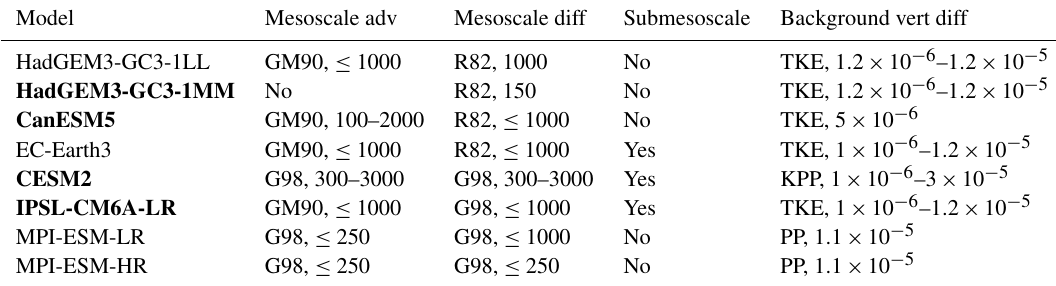
Table 3. Parameterisations of mixing with typical values in m 2 s − 1 . For mesoscale advection and diffusion the models use the formulations in Gent and McWilliams (1990, GM90) and Redi (1982, R82) or the formulation in Griffies (1998, G98). Those models with a submesoscale parameterisation use Fox-Kemper et al. (2011). For vertical diffusivity the models use the turbulent kinetic energy scheme described in Madec et al. (2012, TKE12) or in Madec et al. (2016, TKE16) or the schemes in Pacanowski and Philander (1981, PP) and Large et al. (1994, KPP). Those models which have demonstrated an AMOC hysteresis in this study are in